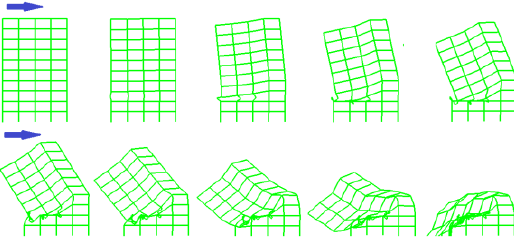
Fig. 17. Progressive collapse of 10-storey frame in fire